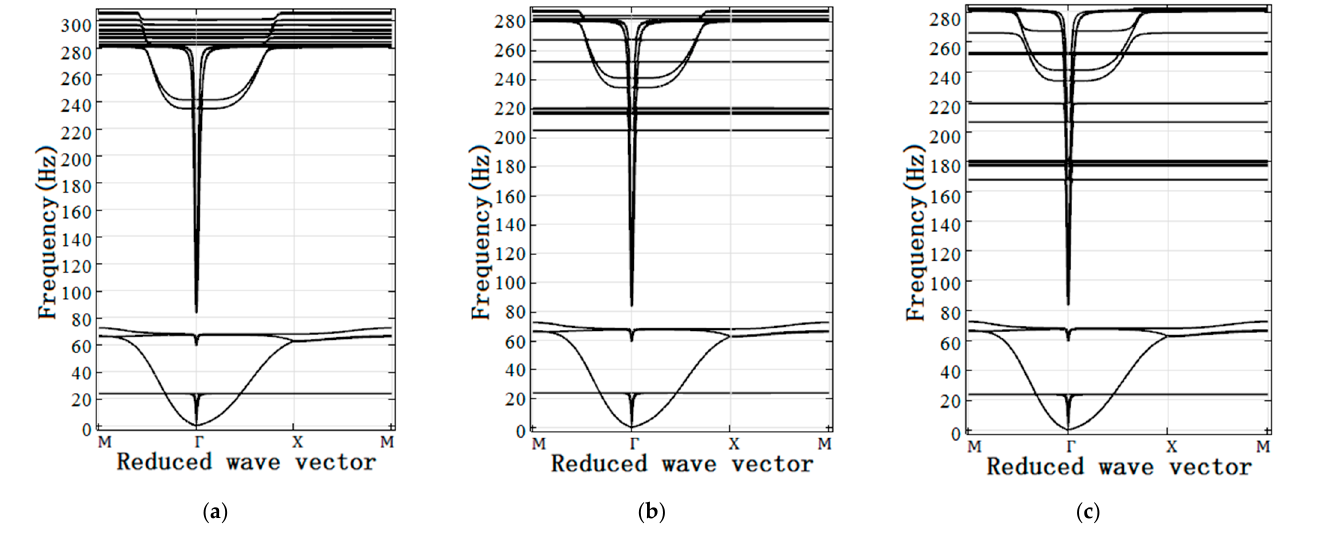
Figure 7. Band structures of LRPC DPSs if the densities of soft shell are ( a ) 𝜌 (cid:3028) (cid:3404) 10 kg/m (cid:2871) , ( b ) 𝜌 (cid:3028) (cid:3404) 20 kg/m (cid:2871) and ( c ) 𝜌 (cid:3028) (cid:3404) 30 kg/m (cid:2871) , respectively.